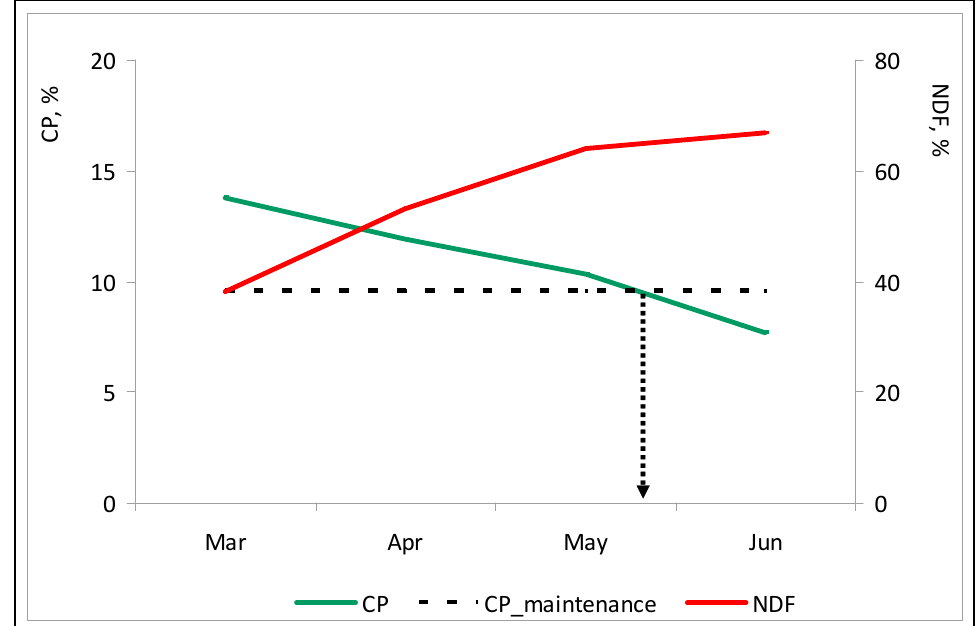
Figure 21. Evolution between March and June 2016 of the pasture nutritive value parameters (crude protein, CP, and neutral detergent fibre, NDF) in all the twenty four sampling points. The arrow indicates the sheep maintenance requirements in terms of CP.